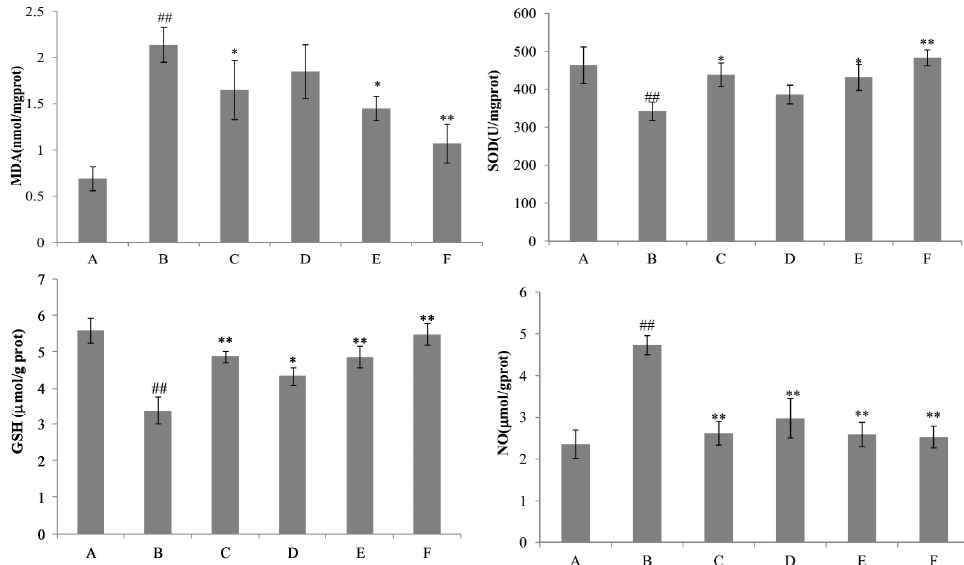
Figure 8. Effects of nicotiflorin on hepatic homogenate SOD, MDA, GSH, and NO in D -GalN-intoxicated mice. (A) Control group; (B) D -GalN-treated group; (C) D -GalN and DDB (150 mg/kg bw)-treated group; (D) D -GalN and nicotiflorin (25 mg/kg bw)-treated group; (E) D -GalN and nicotiflorin (50 mg/kg bw)-treated group; and (F) D -GalN and nicotiflorin (100 mg/kg bw)-treated group. Values are mean ± S.E.M., n = 10. ## p < 0.01 compared with the control group. * p < 0.05, ** p < 0.01 compared with the D -GalN group.